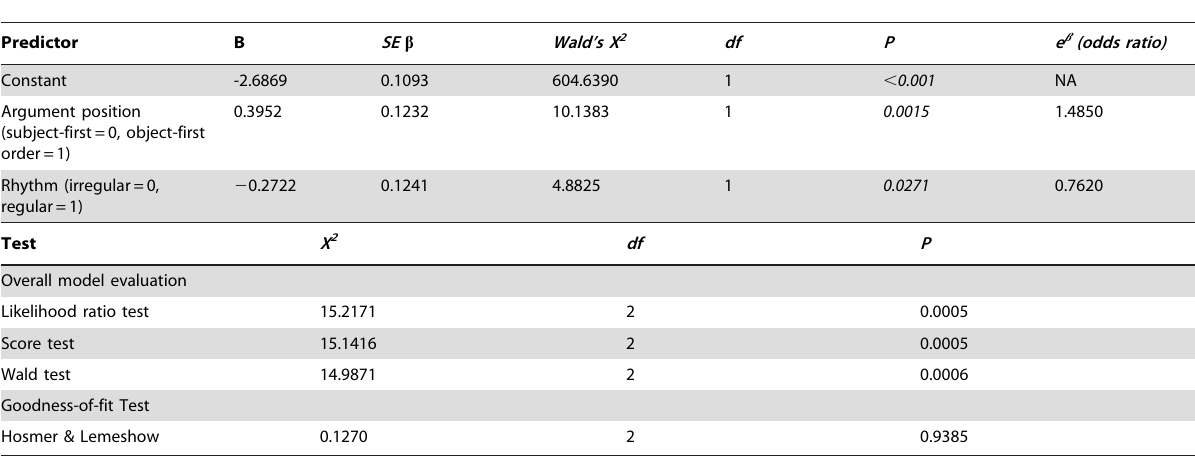
Table 1. Logistic regression analysis of participants’ accuracy rates.